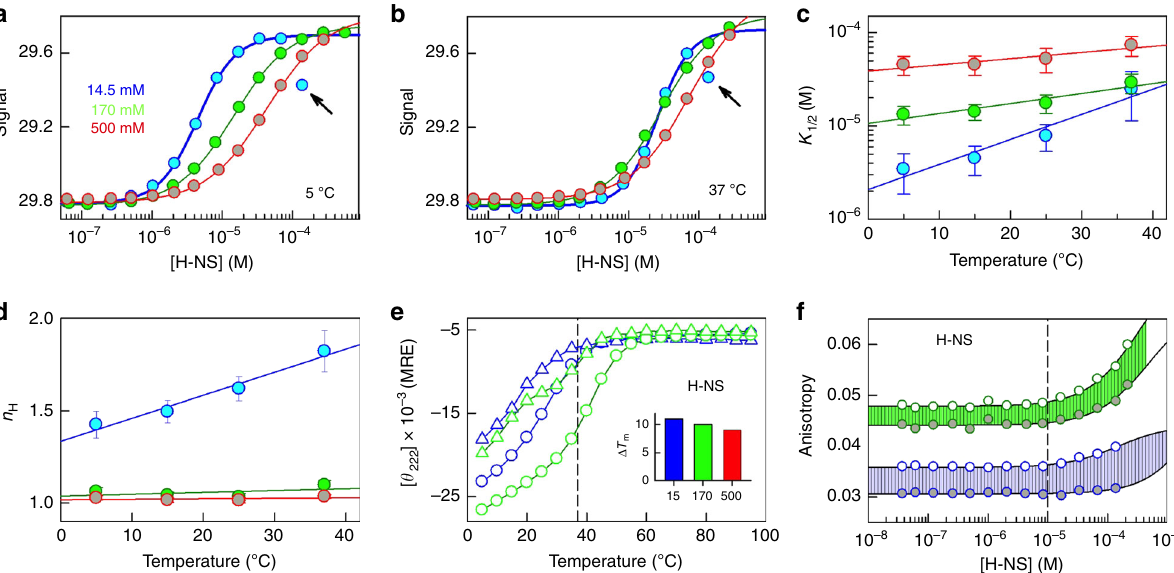
Fig. 5 Switching binding cooperativity upon ionic strength modulations. Blue, green, and red represent 14.5, 170, and 500 mM ionic strength, respectively. a , b Binding isotherms at 5 °C ( a ) and 37 °C ( b ). The binding reaction was followed by the intensity averaged wavenumber represented as Signal in the ordinate (see Methods). Note that there is a roll-over at high H-NS concentrations (arrow). The curves are fi t to Hill binding equations. c , d The mid-point of binding in units of dissociation constant ( K 1/2 ; c ) and Hill coef fi cients ( n H ; d ). The lines through the points are shown to guide the eye. e Far-UV CD monitored thermal unfolding curves of H-NS at concentrations of 6 μ M (triangles) and 18 μ M (circles) at 14.5 (blue) and 170 mM IS (green). Note that H- NS is fully unfolded at 37 °C at both the ionic strength conditions and at low protein concentrations (dashed line). (Inset) The difference in melting temperatures between the two H-NS concentrations at the three ionic strength conditions calculated as T m (18 μ M) – T m (6 μ M). f Aniostropy titration curves of tryptophan labeled H-NS with tyrosine labeled H-NS to identify the minimum concentration at which H-NS starts to self-oligomerize. It can be seen that there is negligible oligomerization at 14.5 mM (blue) compared to 170 mM IS (green, upshifted by 0.01 units for visual representation). The open and fi lled gray circles represent 5 °C and 37 °C, respectively. The curves are a fi t to 1:1 binding equilibrium. The vertical dashed line signals a minimum oligomerization concentration of 10 μ M in the absence of Cnu (more clearly seen at 170 mM IS). Error bars show 68% con fi dence intervals. Source data